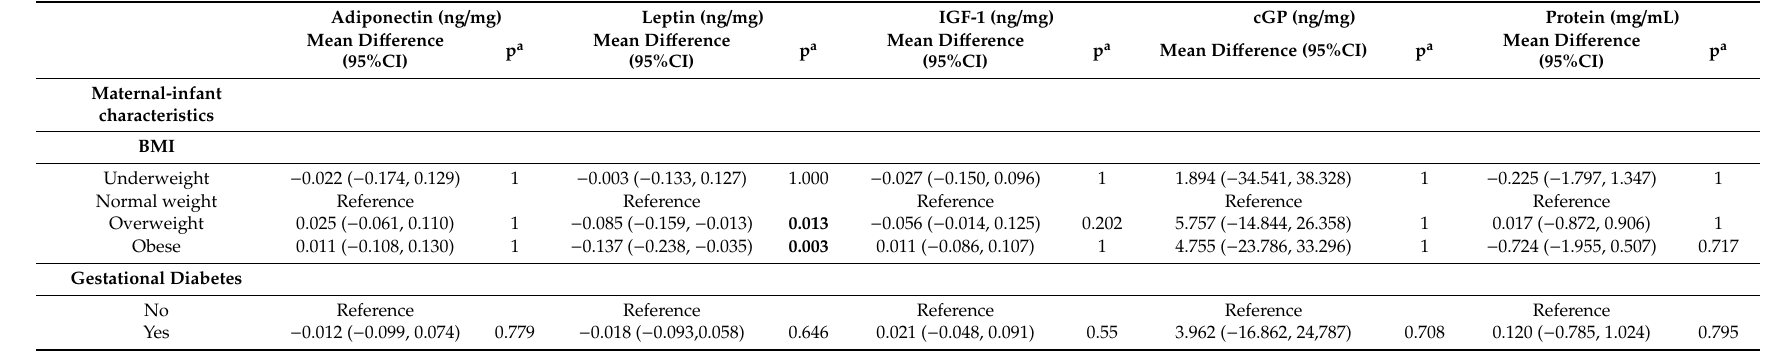
Table 4. Associations between maternal-infant characteristics and HM adiponectin, leptin, IGF-1, cGP and protein according to MANOVA